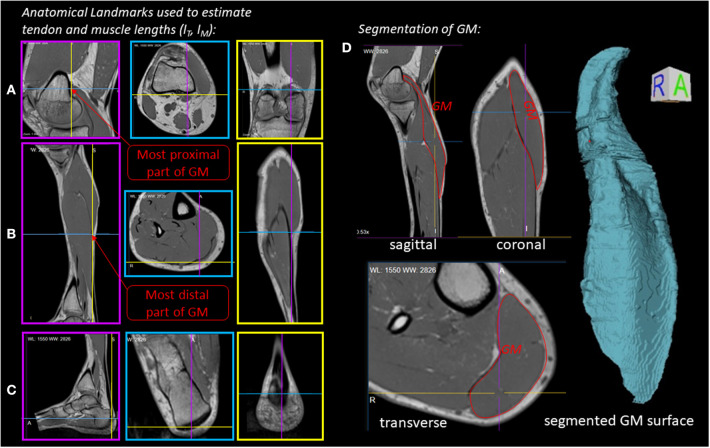
Experiment 1—Determination of muscle morphology: (A–C) Sagittal (magenta boxes), transverse (blue boxes) and coronal (yellow boxes) MRI planes illustrating anatomical landmarks (indicated by line cross-sections), which were identified to determine the tendon (lSEE) and muscle lengths (lCE). (D) Manually segmented GM muscle and corresponding GM surface.